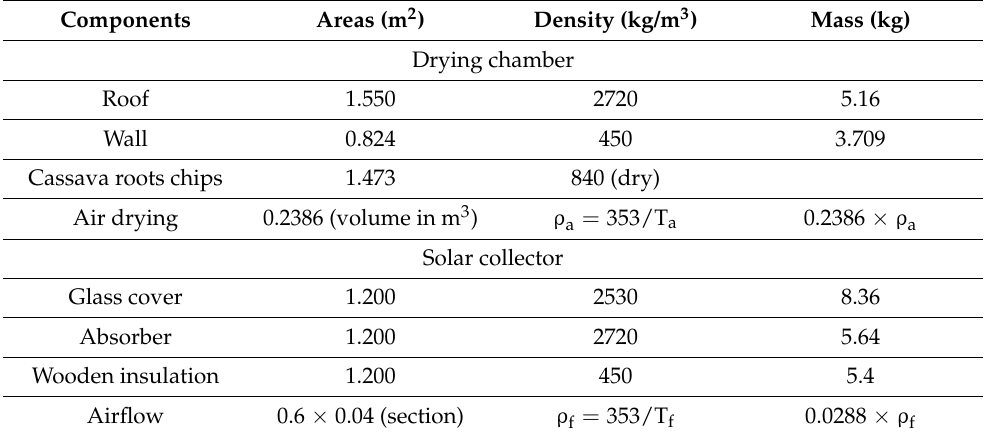
Table 1. Physical properties and characteristics of the components of the solar dryer [13].